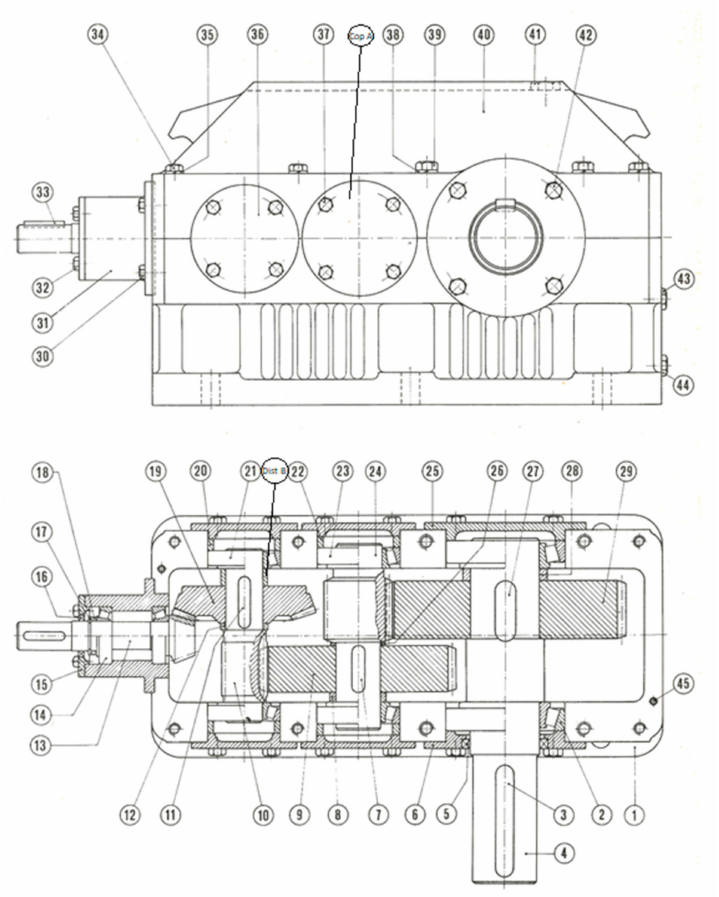
Figure 1. Technical 2D drawing of the orthogonal axis speed